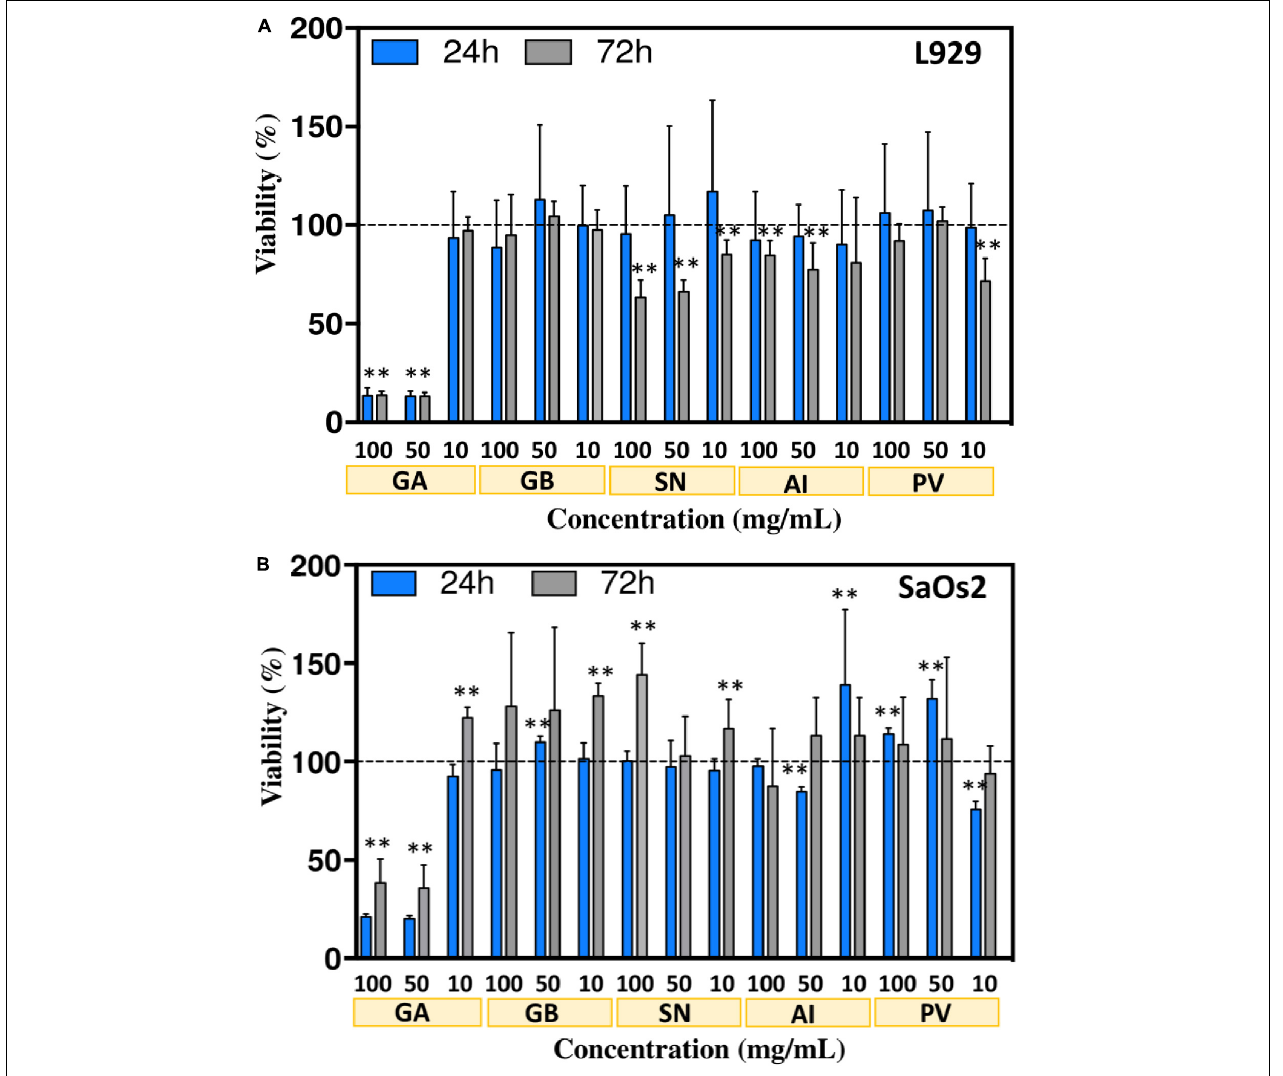
FIGURE 7 | Viability of L929 (A) and SaOs2 (B) cells, measured using the AlamarBlue assay, when cultured in contact with different concentrations of the extracts from the sponge-based biosilicas, i.e., 10, 50, and 100 mg/mL. Metabolic activity was evaluated after 24 and 72 h of cell culture. The data are presented as mean ± SD and the statistical differences are represented with ∗ for p < 0.05 and ∗∗ for p <